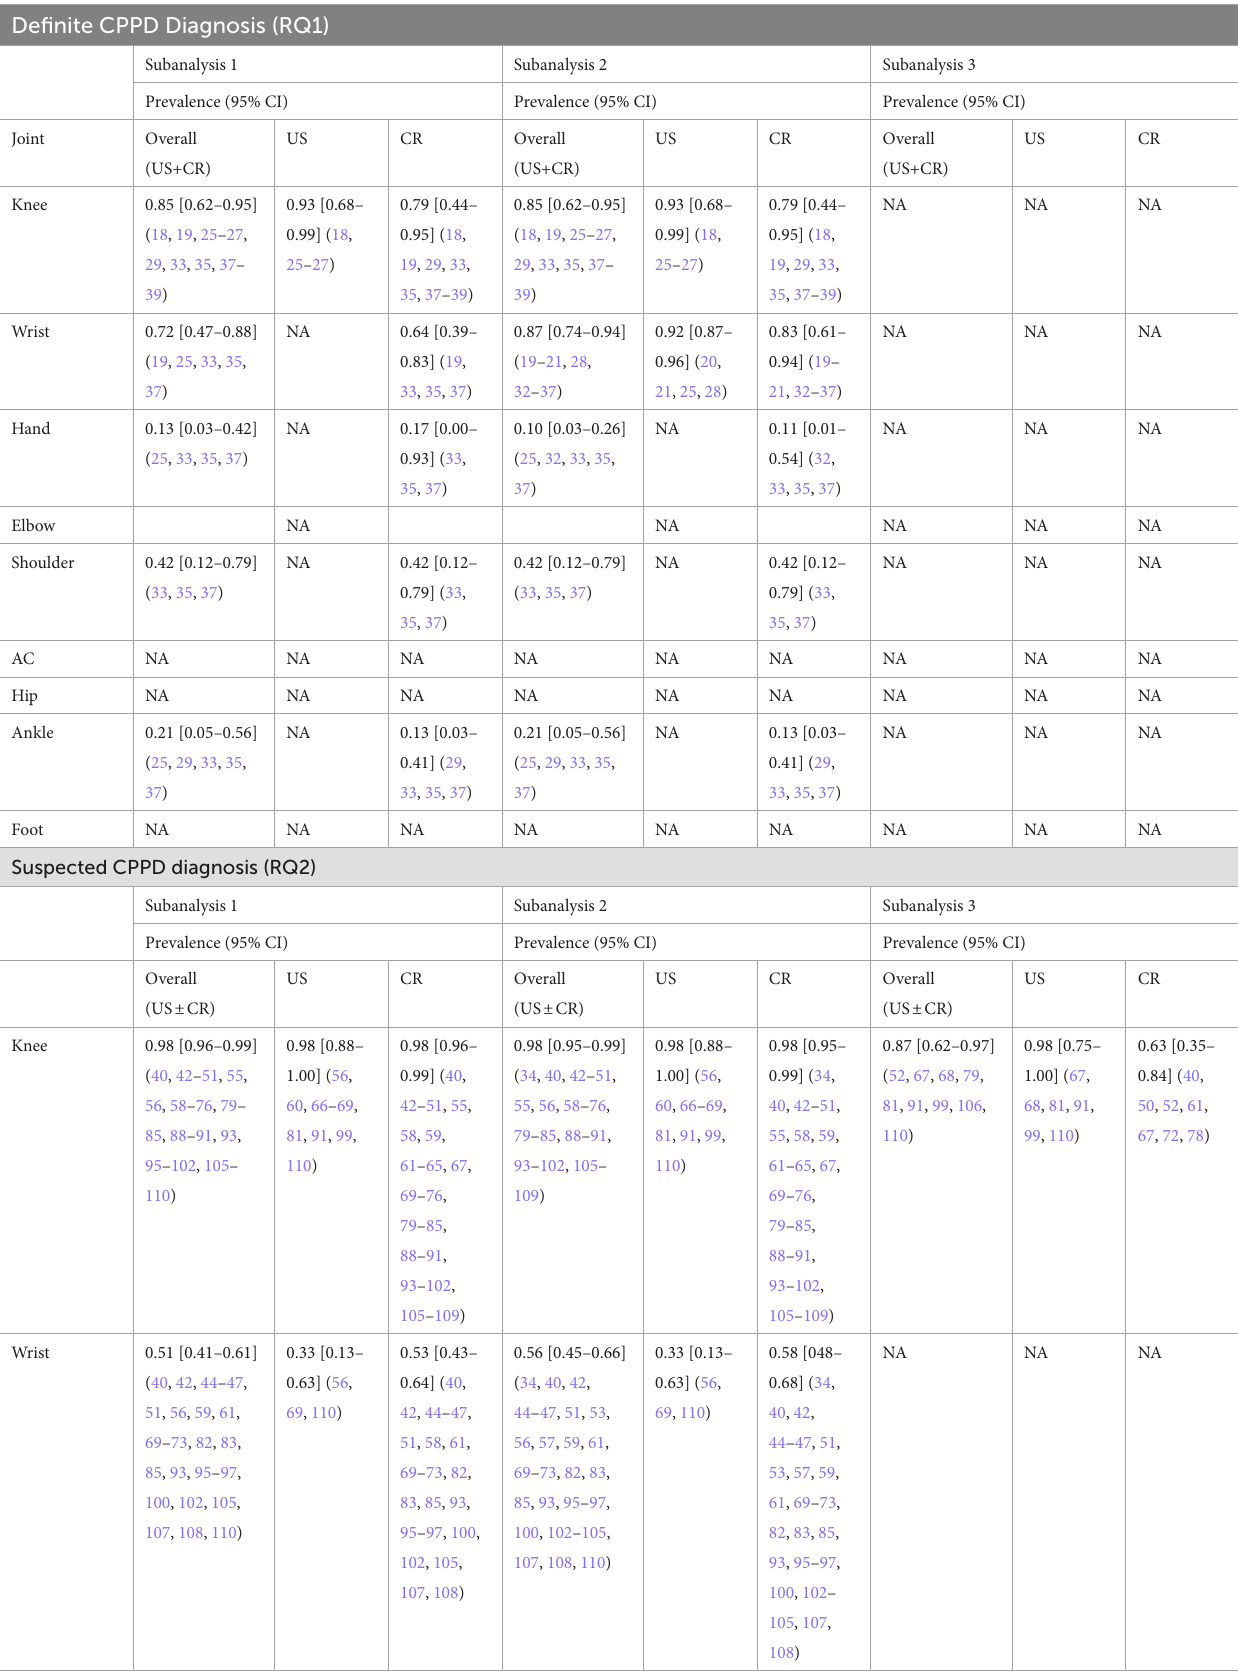
TABLE 3 Meta-analyzes